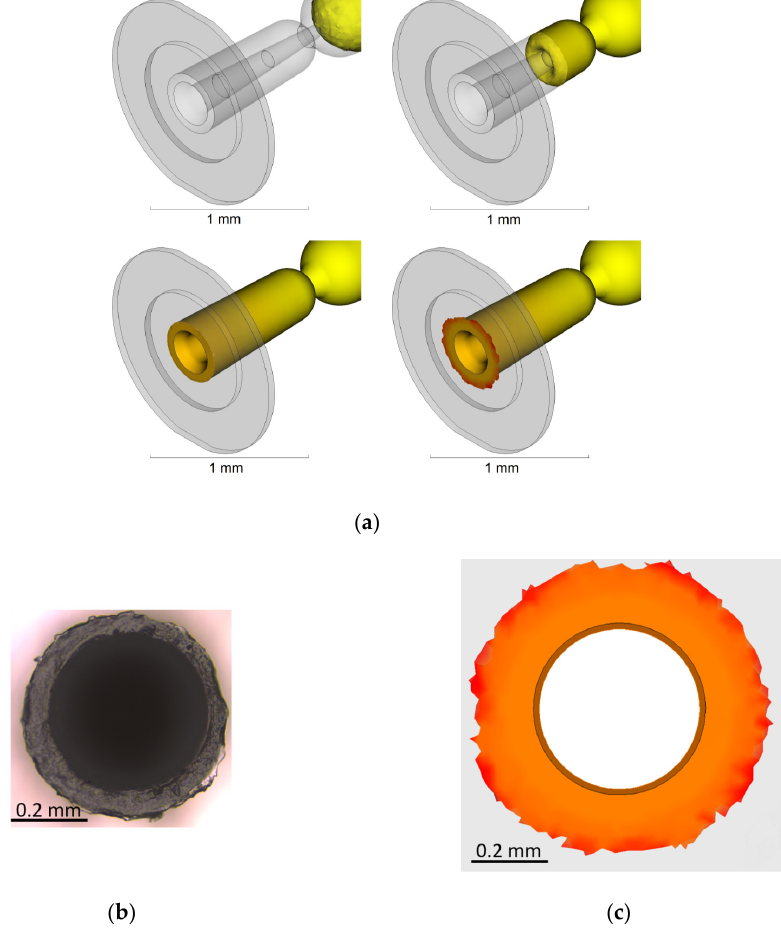
Figure 9. ( a ) Simulated flash formation during cavity filling; ( b ) real flash on the part; and ( c ) simulated flash (the dimensional scale bar is equal in both images) [31].